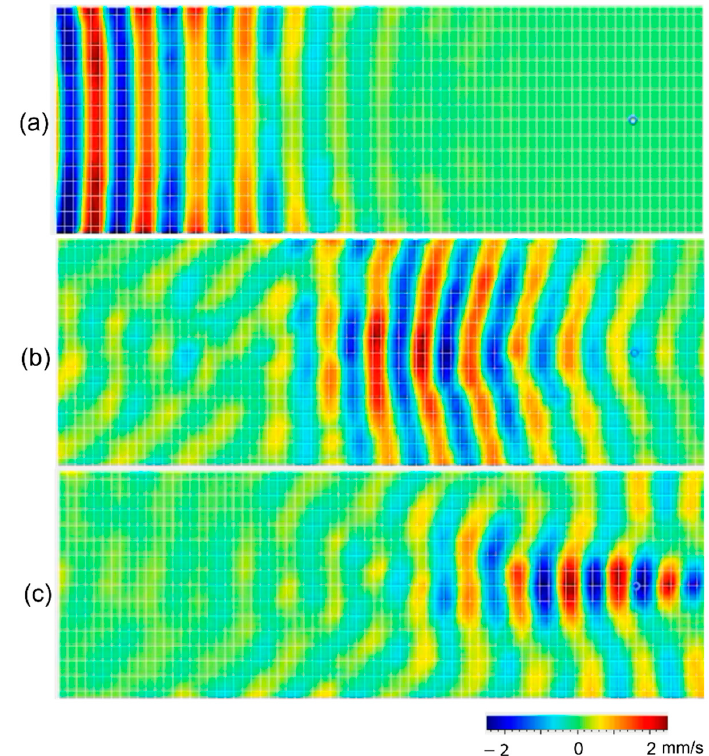
Figure 4. LDV measurement showing the z-directional surface velocity of 50 kHz A 0 mode Lamb waves at ( a ) 210 µs, ( b ) 284 µs, and ( c ) 323 µs.